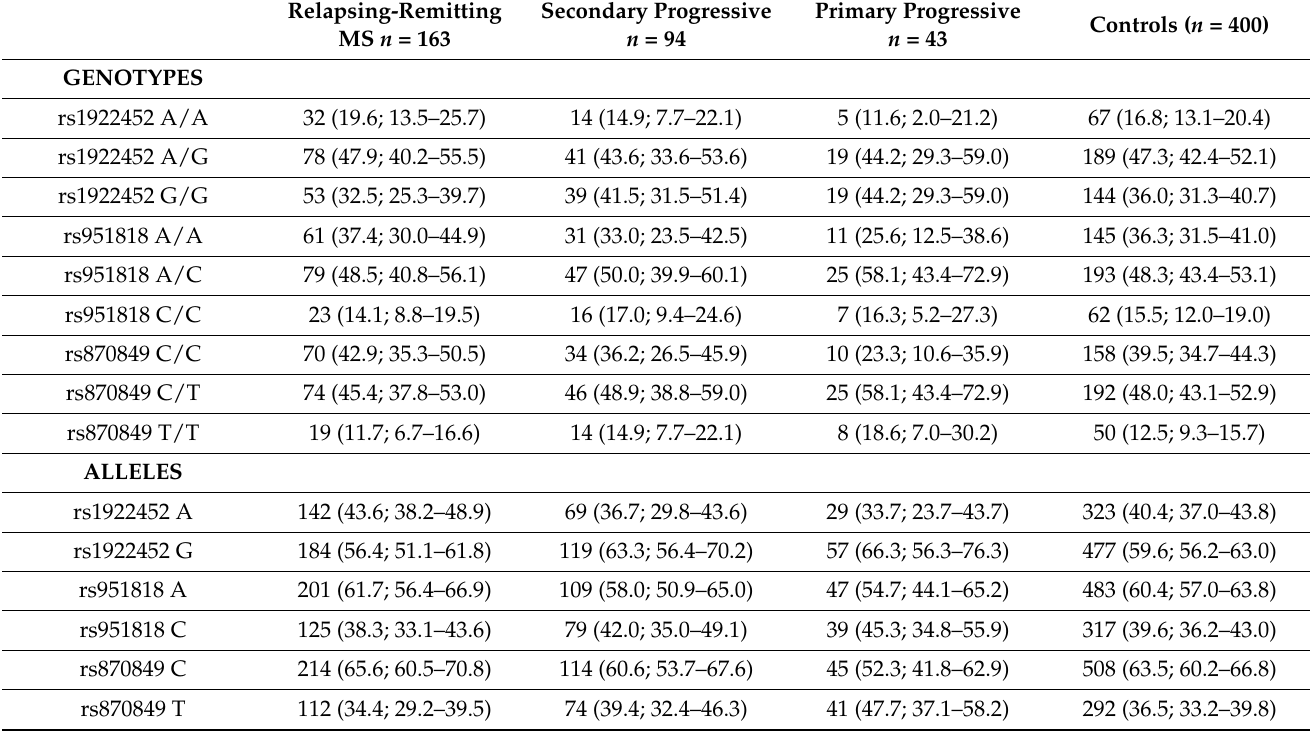
Table 5. Genotypes and allelic variants of patients with MS according to the evolutive type of MS. The values in each cell represent the number (percentage; 95% confidence intervals).